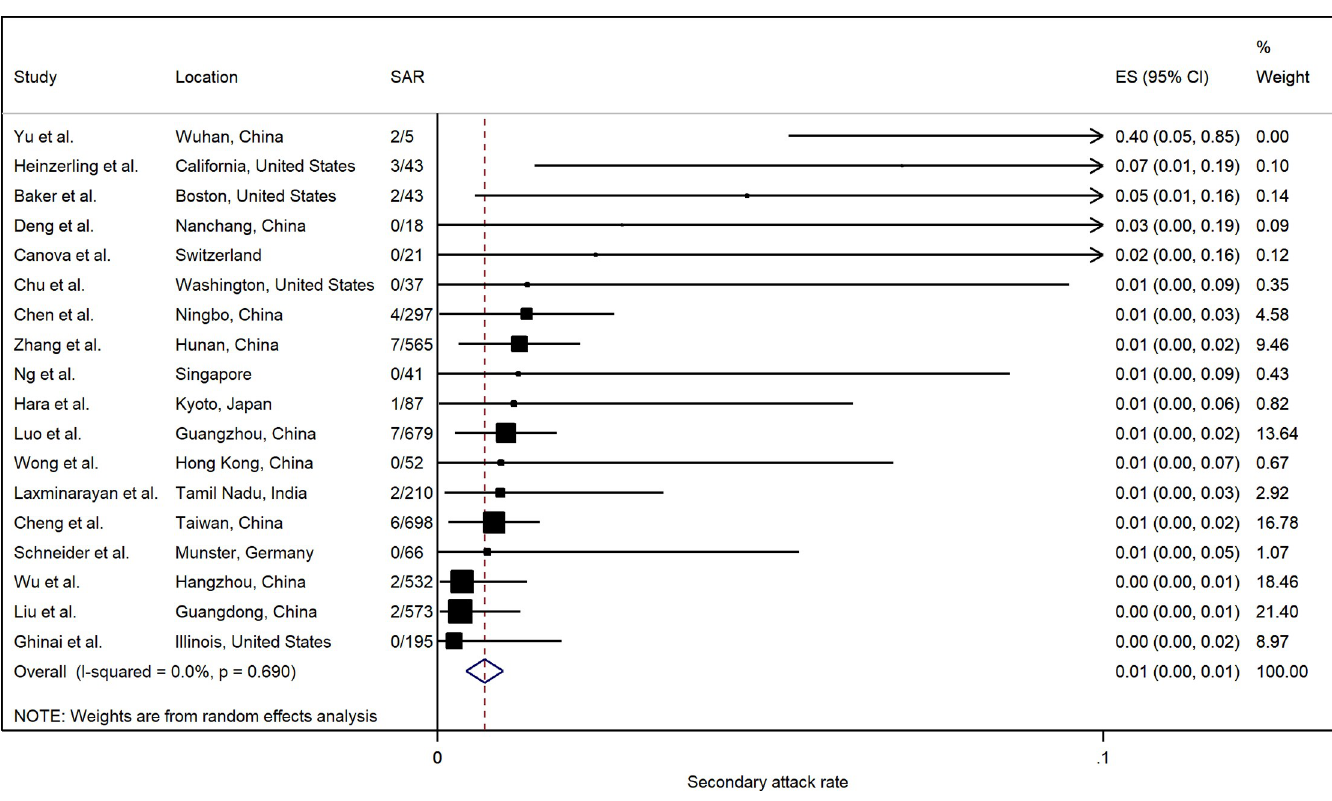
PLOS ONE | https://doi.org/10.1371/journal.pone.0240205 October 8,